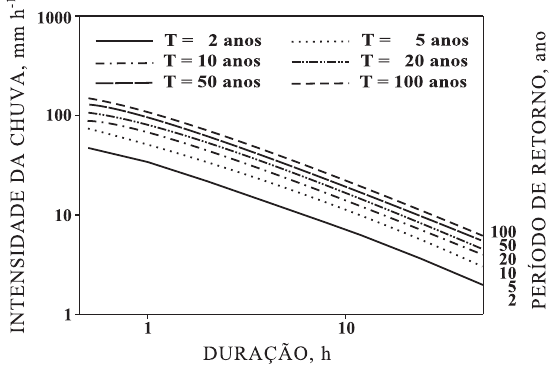
Figura 2. Períodos de retorno esperados (T), em anos, das chuvas em Rio Grande-RS, em função da sua intensidade e